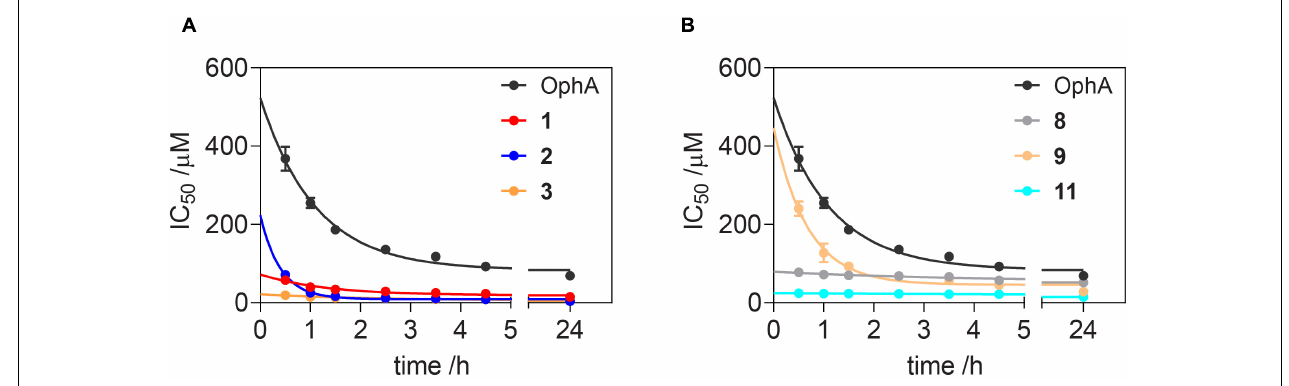
FIGURE 2 | Benzazulenones have higher IC 50 with less change over time as compared to OphA. Change of effective CaM-binding affinity over time of OphA and formyl aminobenzazulenones (A) and aminobenzazulenones (B) as measured in the fluorescence polarization assay using F-PMCA peptide as the fluorescent probe. Data represent mean values ± SD, n = 2. Binding curves are plotted in Supplementary Figures 2A,B . Derived rate analysis plots are in Supplementary Figures 2G,H .